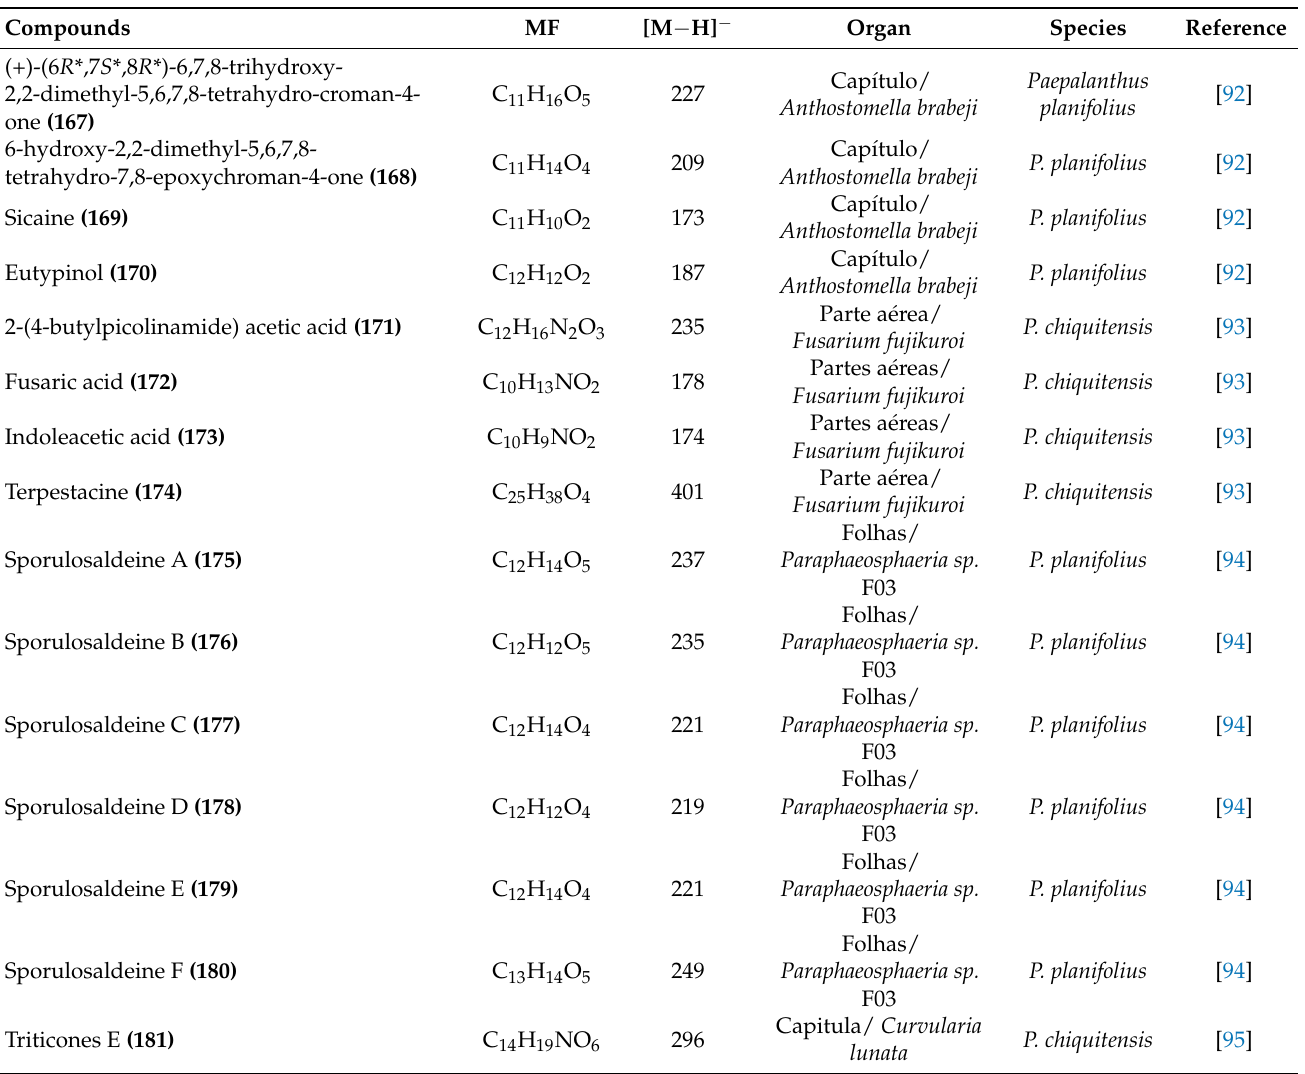
Table 3. Compounds of endophytic fungi isolated from Paepalanthus species.